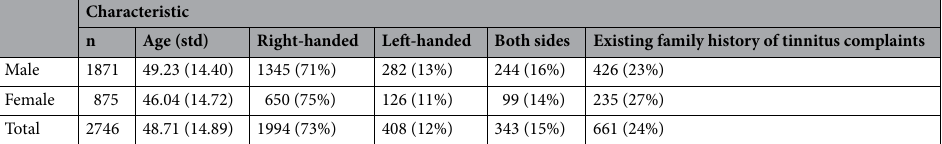
Table 4. Baseline characteristics of the Tinnitus Sample Case History Questionnaire (TSCHQ) for all individuals that filled out at least one follow-up questionnaire. Individual users that registered for this study, but did not fill out at least one follow-up questionnaire, are not considered in this table.